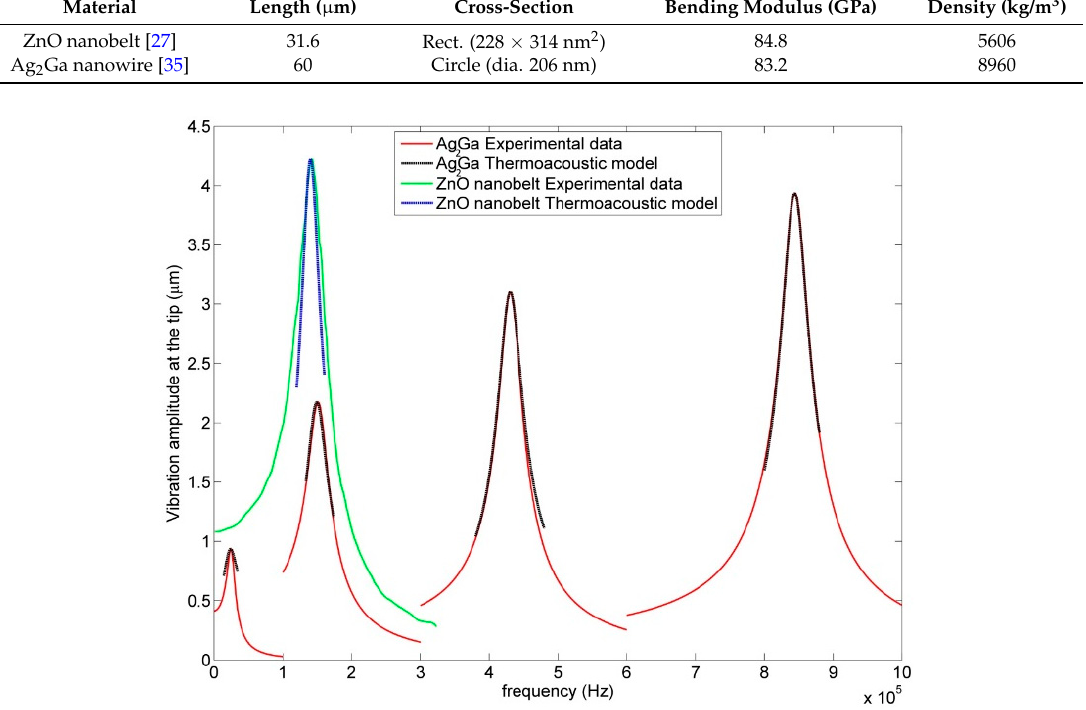
Figure 4. Frequency response function of Ag 2 Ga nanowire and ZnO nanobelt resulted from experimental data and thermoacoustic model. The results of experimental data and thermoacoustic model match. Table 1. Properties of ZnO nanobelt and Ag 2 Ga nanowire.